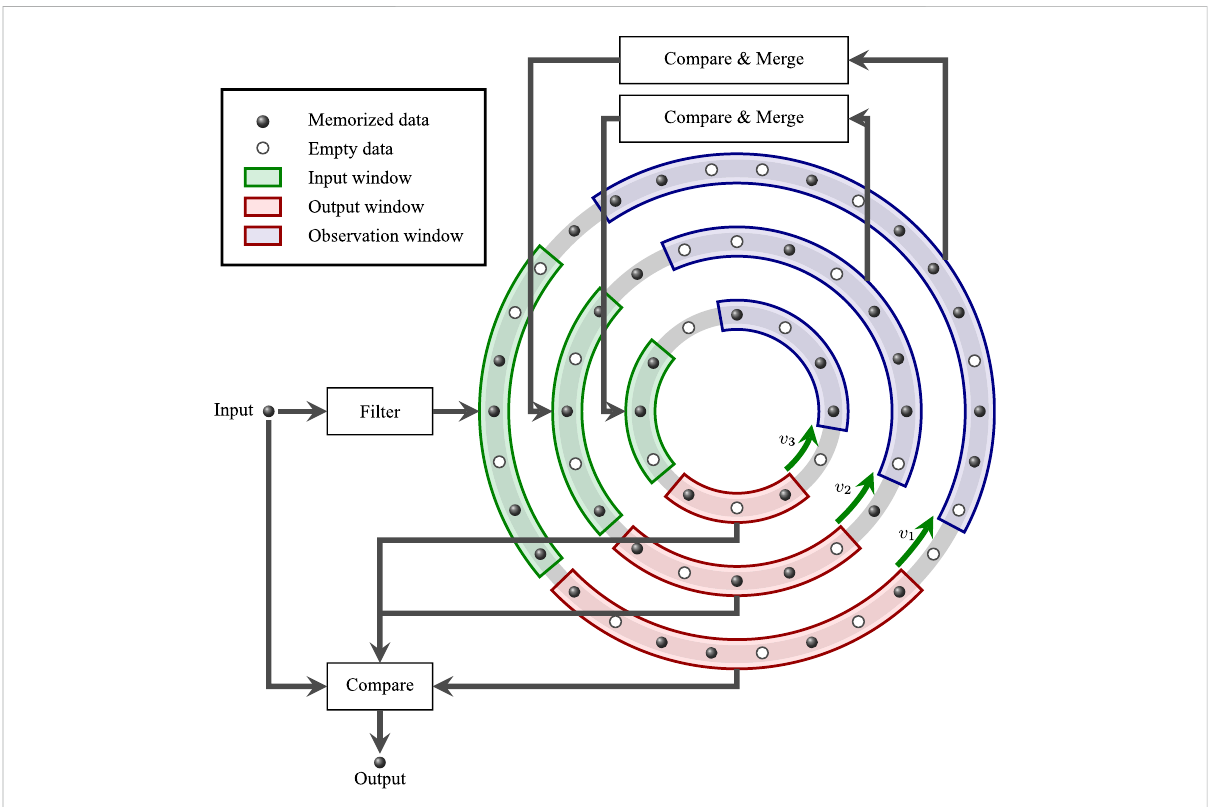
FIGURE 1 SchematicofMRMmodel,theinputinformationentersthreelayersofconcentricringsrepresentingthreedifferentmemoryspacesthrougha fi lter unit, and the concentric rings rotate at different speeds, so that the input information can be transmitted to different locations in the memory